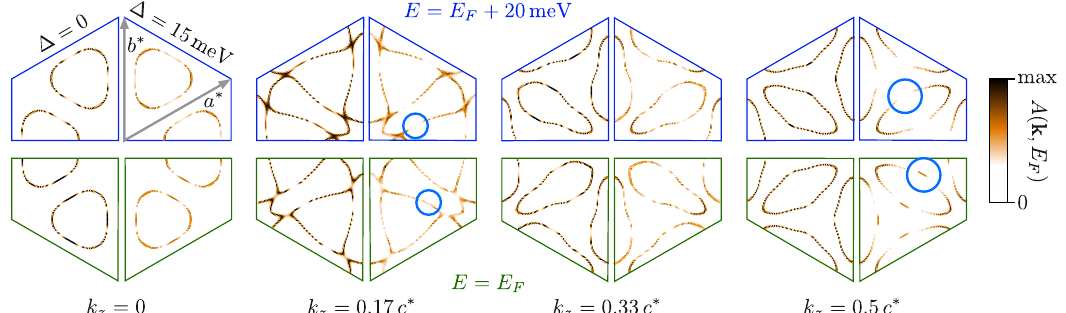
Figure 8: The spectral function of VSe of each plot shows the ungapped(gapped) phase above(below) T half of each plot shows the spectral function 20 meV above E employ the same colour scale. We employed a spectral broadening of Σ = 15 i meV, and a constant gap ∆ = 15 meV. The blue circles highlight regions regions separated by one CDW